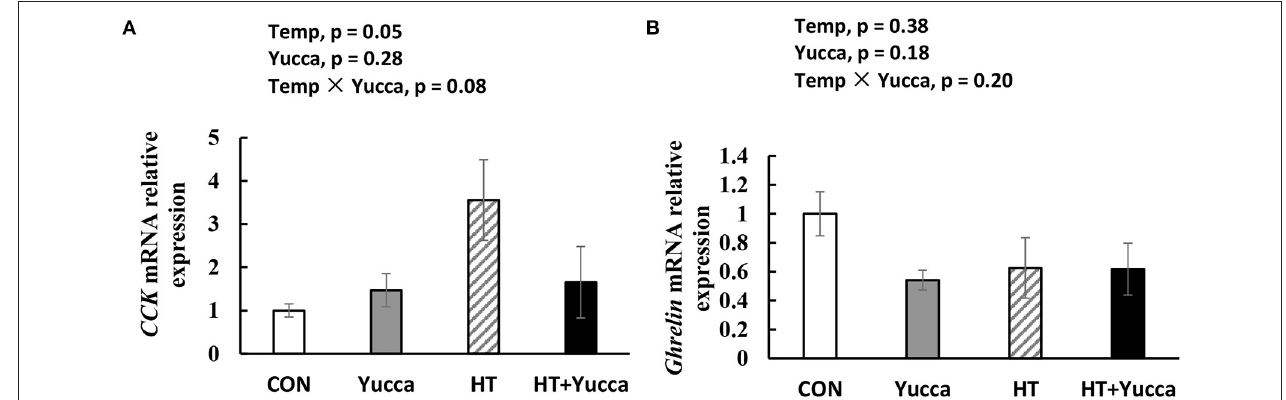
FIGURE 5 | Duodenal mRNA expression of CCK (A) and Ghrelin (B) in broilers. Broilers, of 28 days ofage, were fed a basal diet and exposed to 24 ◦ C (CON) or 34 ◦ C (HT), or a basal diet supplemented with 0.1% yucca and exposed to 24 ◦ C (Yucca) or 34 ◦ C (HT + Yucca) for 4 wks. Values are means ± SE, n = 6.